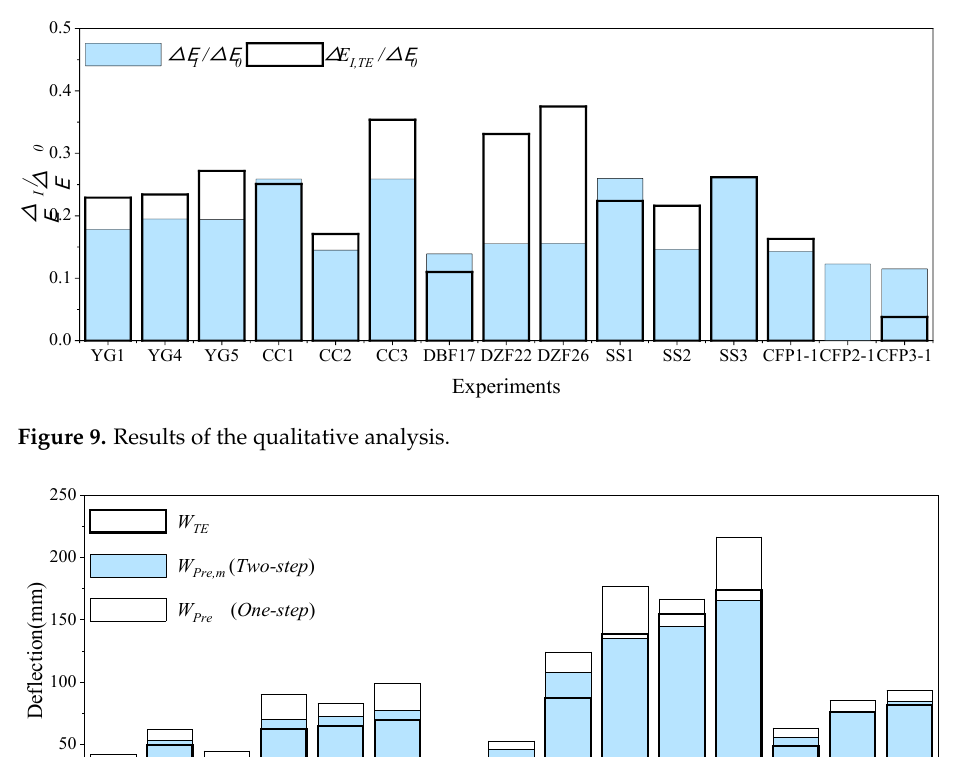
Figure 8. Design process of the two-step design.